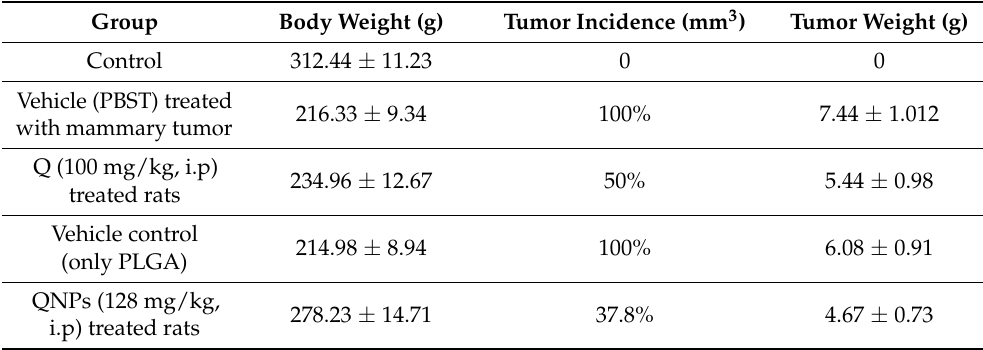
Table 2. Effect of QNP on body weight (g), tumor incidence (mm 3 ) and tumor weight on experimental group of